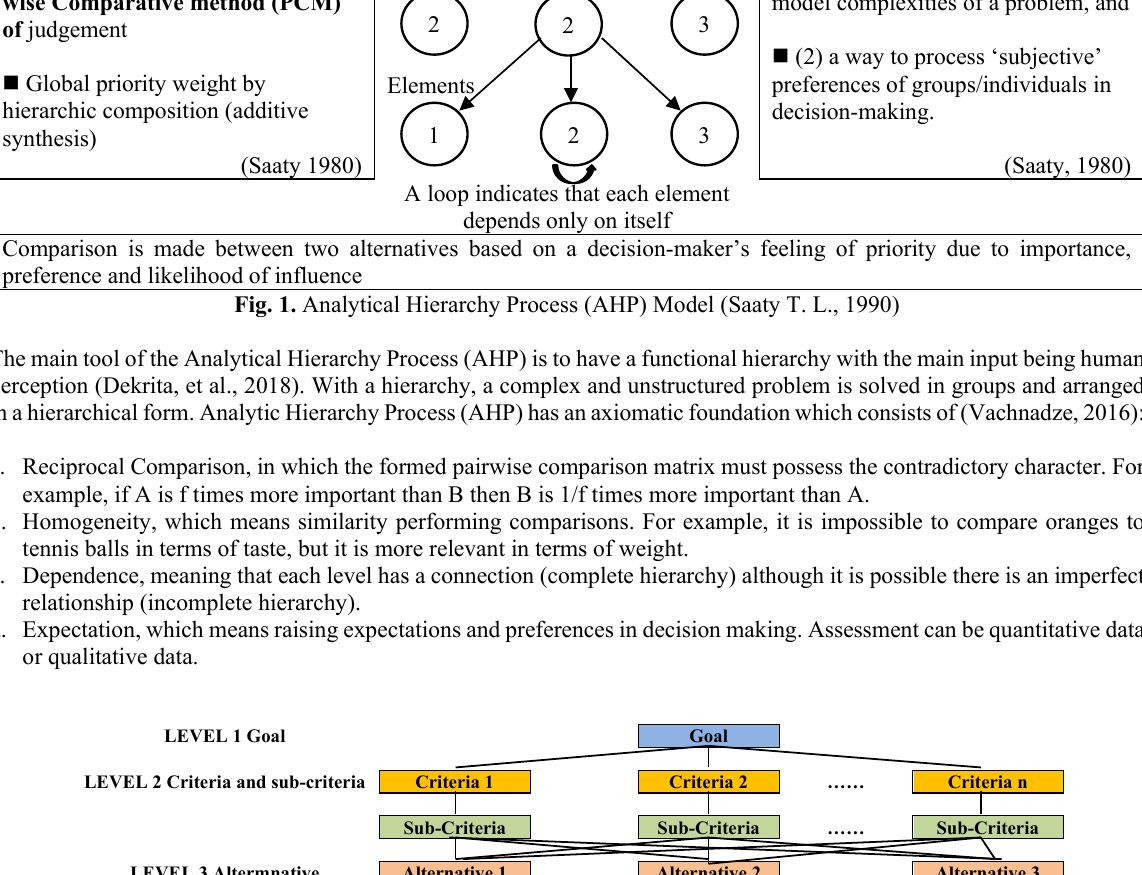
Fig. 2. Hierarchy Model in AHP (Vachnadze,